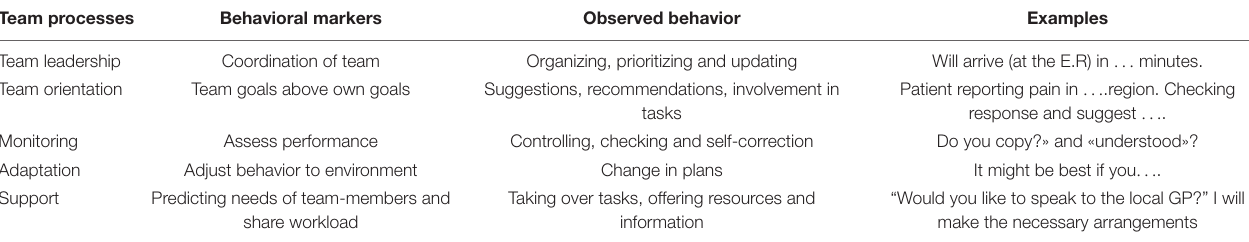
TABLE 1 | Big-five team processes based on Salas et al. (2005) including behavioral markers, generic observed behavior and